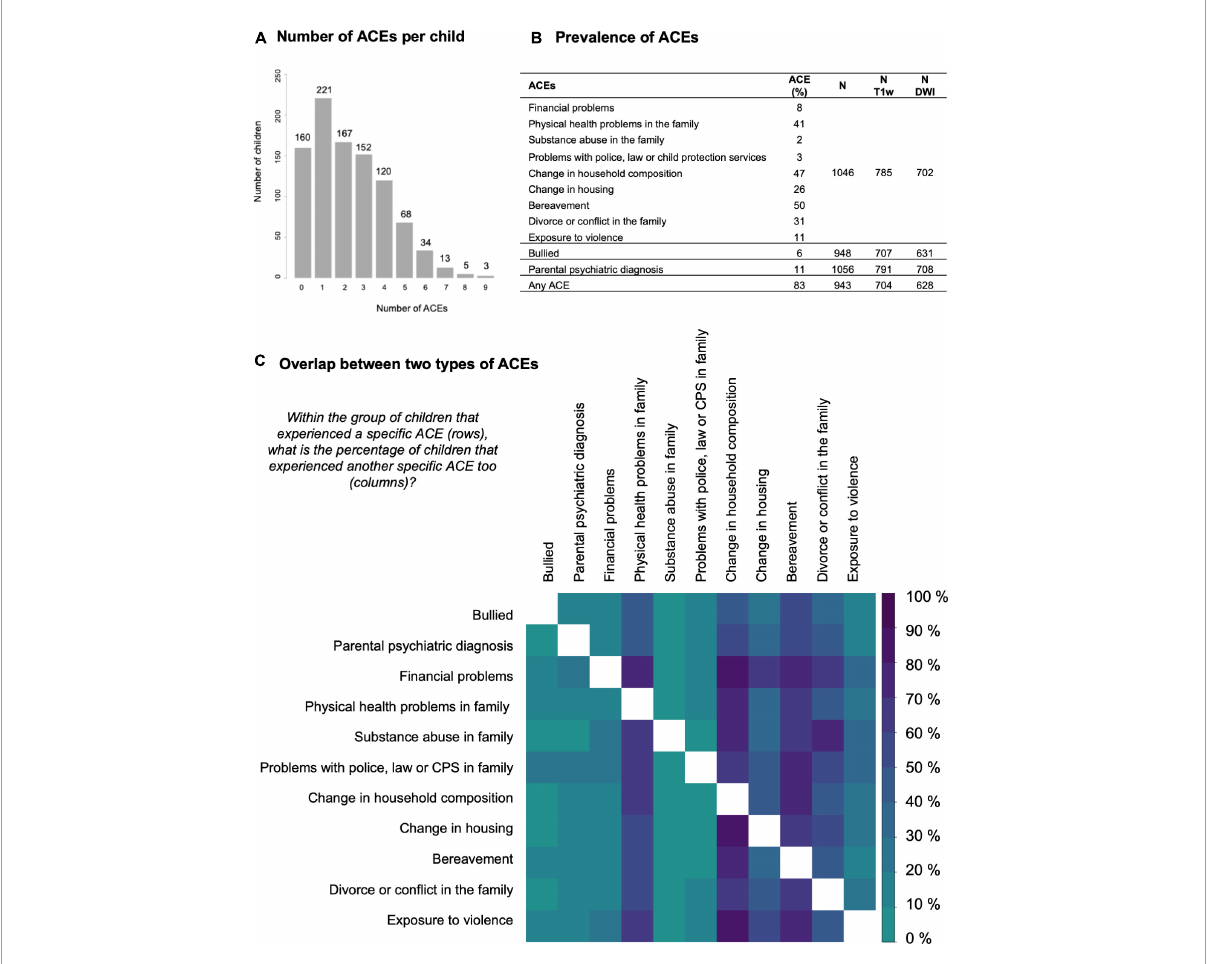
FIGURE2 Descriptive statistics for the exposure to ACEs. (A) Histogram of the number of adverse childhood experiences (ACEs) per child. (B) Table with the prevalence of specific ACEs in our sample. Borders between the rows indicate a different data source: 9 ACEs from the life events survey, 1 from the bullying survey, 1 from the health survey, and 1 composed from all three surveys. The prevalence of ACEs was similar in the total group compared to the subsets with MR data available. The last columns list the sample size for each data source in the total group and in the subsets with T1-weighted MRI data or diffusion-weighted imaging data available. (C) Matrix visualizing the overlap between two types of ACEs. Darker colors represent a higher overlap (in percentage) between children with one ACE (row) and a second ACE (column). The upper and lower triangle are not symmetric because the percentage is based on the subset defined in the row. The diagonal is masked out